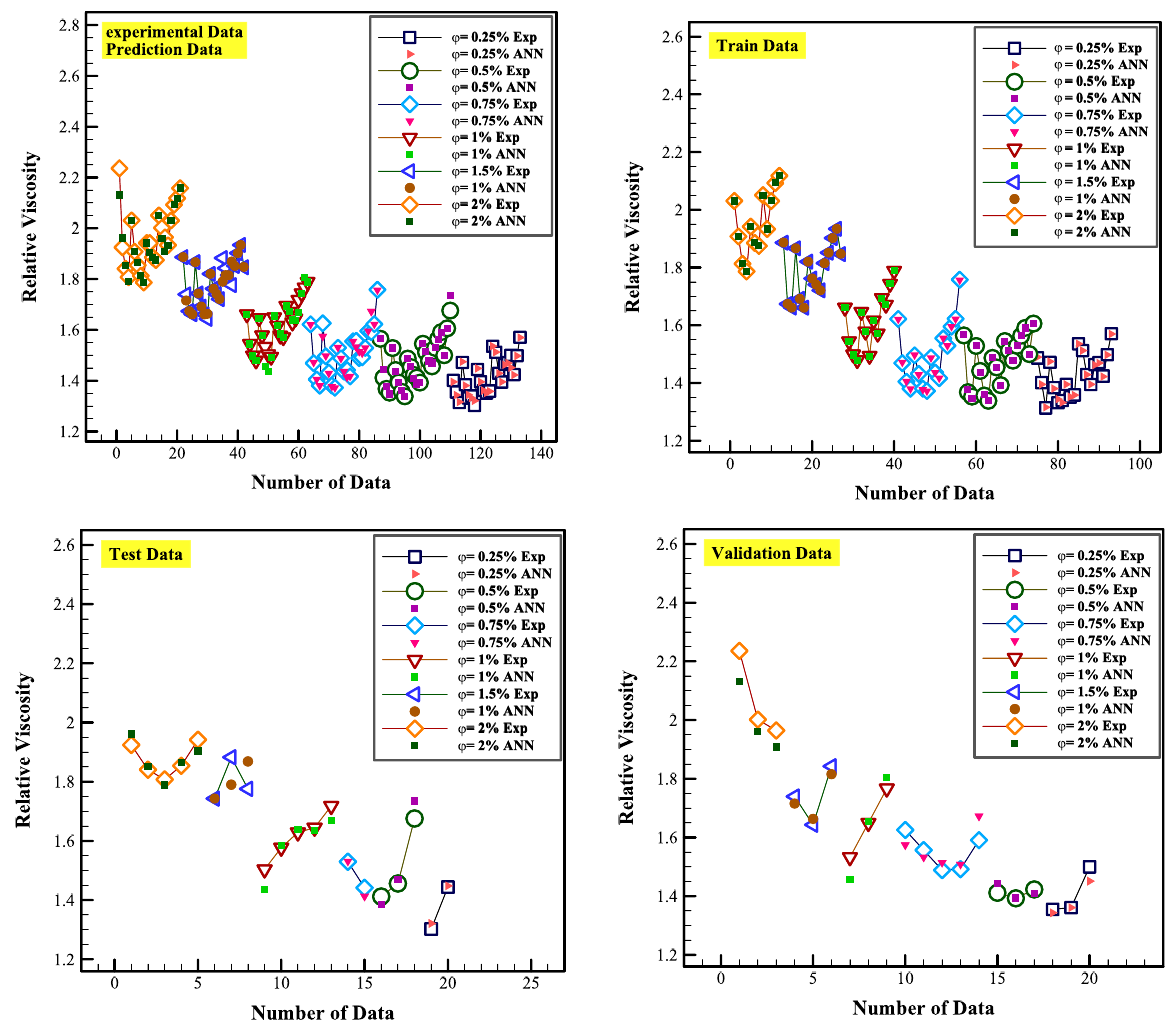
Figure 6. Comparison between the experimental data and the data predicted by the